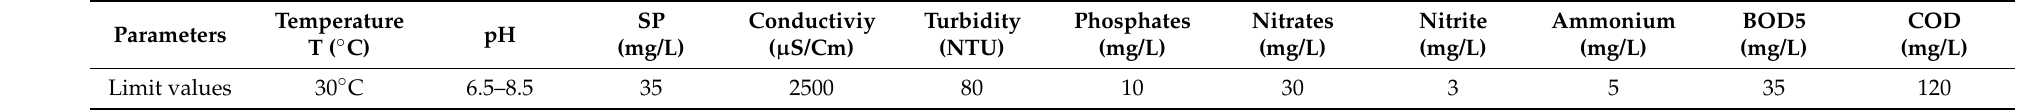
Table 1. Limit values of some physicochemical parameters of pollution in industrial rejection in